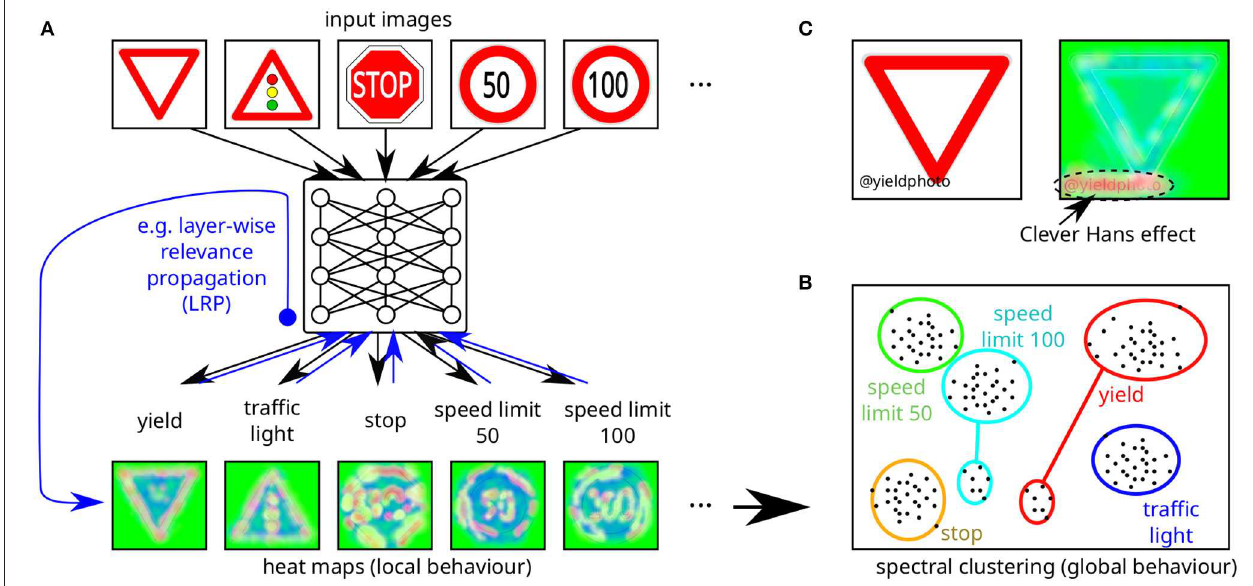
FIGURE 8 | Schematic illustration of the application of explainable AI (XAI) methods to deduce (A) local and (B) global model behavior of an AI system. (A) shows how heat maps are generated after labels were obtained for a specific input image, in this case using LRP (Samek et al., 2016), which assigns each input pixel a relative contribution to the output decision (green colors indicate lowest relevance, red colors highest relevance). (B) illustrates how many local model behavior explanations are combined to explain global model behavior, in this case using spectral analysis (cf. Lapuschkin et al., 2019). Here multiple topographically distinct clusters for individual labels shown in a 2D projection of input space indicate some kind of problem: the small cluster for speed limit 100 represents the backdooring attack using modified stop signs (cf. Figure 4 ) and the small cluster for the yield sign represents the Clever Hans effect illustrated in detail in (C) , where specific image tags (here “@yieldphoto”) correlate with specific input classes (here the yield sign) and the AI system focuses on these spurious correlations instead of causal correlations. Upon swapping the input data set (not containing any more spurious correlations of this kind), the AI model might show erroneous behavior.